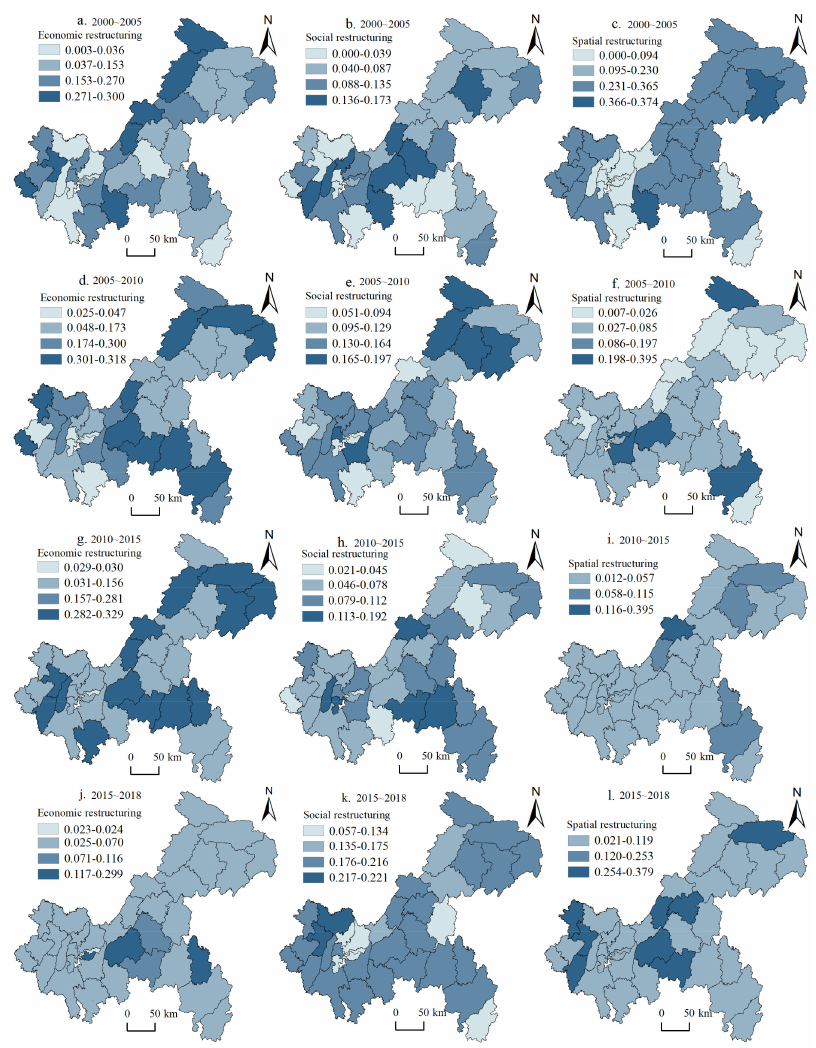
Figure 3. Spatial pattern of rural restructuring intensity in